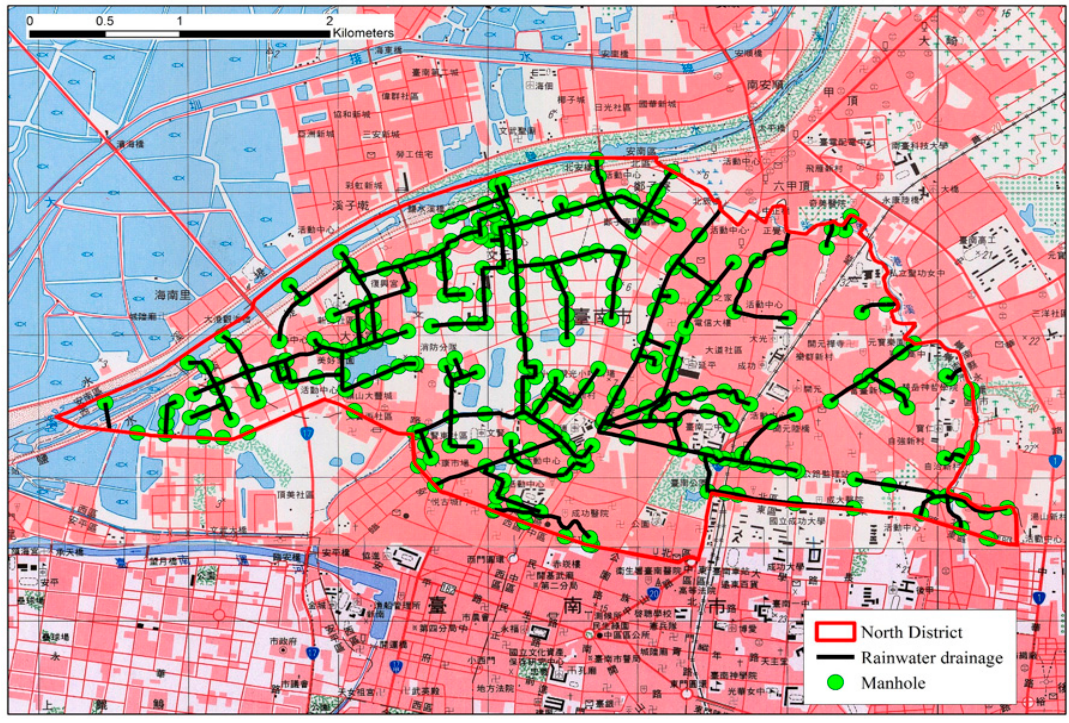
Figure 5. Sewer system in North District of Tainan City.